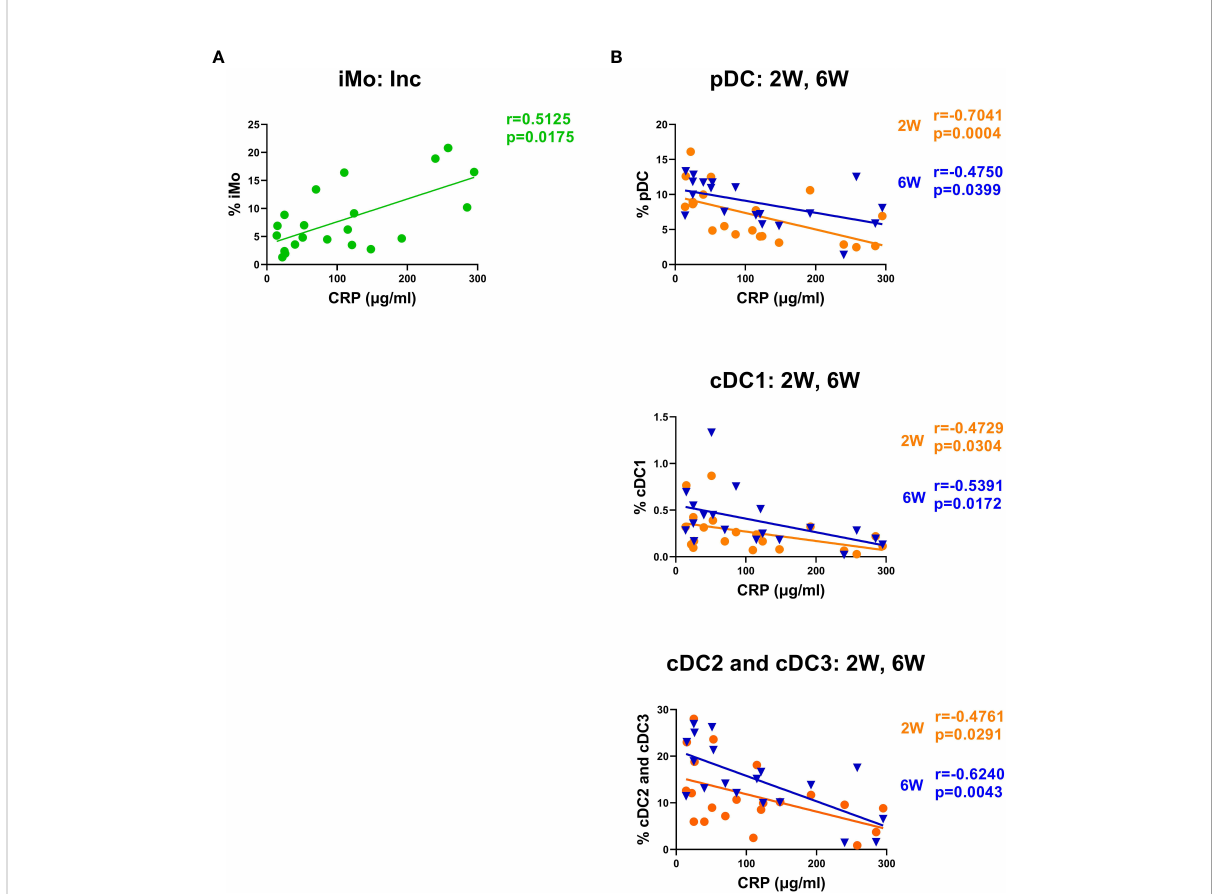
FIGURE 8 CRP levels correlated negatively with intermediate monocyte levels and with the recovery of DC subsets. Bivariate analysis with Spearman ’ s correlation coef fi cient was performed using an array of clinical parameters and myeloid cell types. Signi fi cant correlations shown for (A) iMo at inclusion and (B) circulating DC subsets at 2 and 6 weeks post-inclusion, all against CRP. The p value and Spearman ’ s correlation coef fi cient (R) are shown for each analysis. N = 21. Inc, Study inclusion; 2W, 2 weeks; 6W, 6 weeks; 6M, 6-7 months; HC, healthy